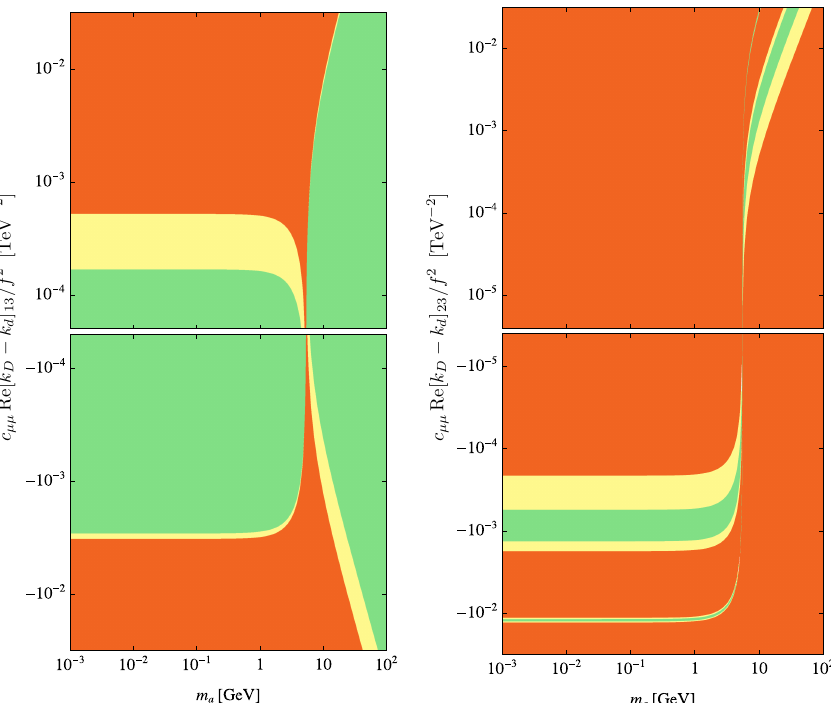
Figure 11 . Left: constraints on the ALP parameter space from the measurement of Br ( B d → µ + µ − ) in the c ( µ ) [ k ] vs m plane. The green and yellow areas respectively lie within 1 σ and µµ b D − k d 13 a 2 σ of the experimental value and the orange region is excluded at 2 σ . Right: parameter space of c ( µ ) [ k ] vs m where the tension in B µµ b D − k d 23 a flavor-violating couplings.